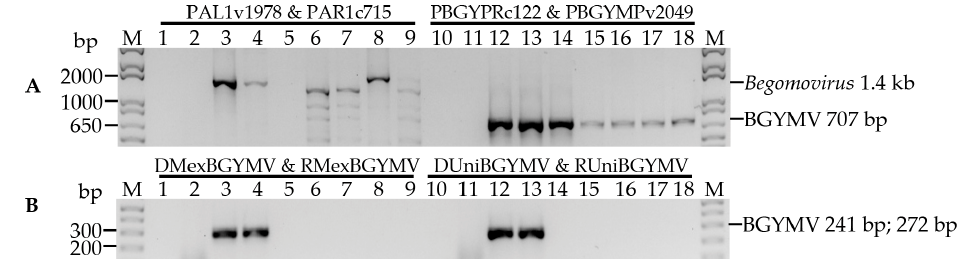
Figure 1. Specificity of four primer pairs for the detection of bean golden yellow mosaic virus (BGYMV) using polymerase chain reaction (PCR). The primer set used in each case is indicated above the lanes ( A ) Primer pairs reported for detection of the genus Begomovirus and for specific detection of BGYMV; ( B ) Primer pairs designed in the present study specifically for BGYMV. Lanes 1 and 10: non template control; lanes 2 and 11: negative control (cDNA from healthy plant); lanes 3 and 12: positive control (cDNA from common bean infected with BGYMV-MX strain); lanes 4 and 13: plasmid DNA of BGYMV-MX DNA A component; lanes 5 and 14: plasmid DNA of BGYMV-MX DNA B component; lanes 6 and 15: plasmid DNA of pepper huasteco yellow vein virus (PHYVV) DNA A component; lanes 7 and 16: plasmid DNA of PHYVV DNA B component; lanes 8 and 17: plasmid DNA of pepper golden mosaic virus (PepGMV) DNA A component; lanes 9 and 18: plasmid DNA of PepGMV DNA B component. M: Molecular marker 1 kb plus DNA ladder.